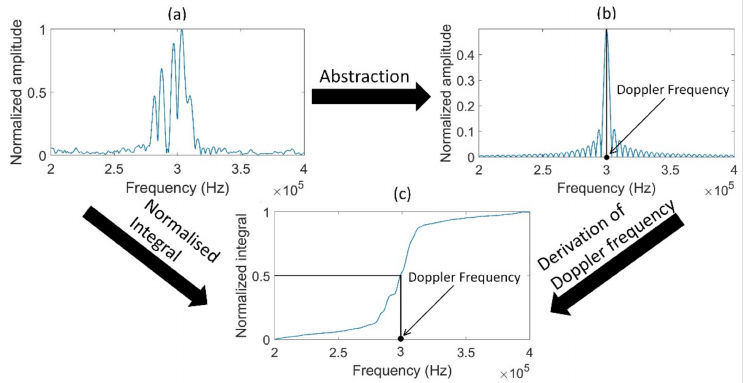
Figure 14. ( a ) Cross-correlation spectrum of a SMI-Signal; ( b ) Integral of the cross-correlation spectrum; and ( c ) Abstraction of the cross-correlation spectrum.